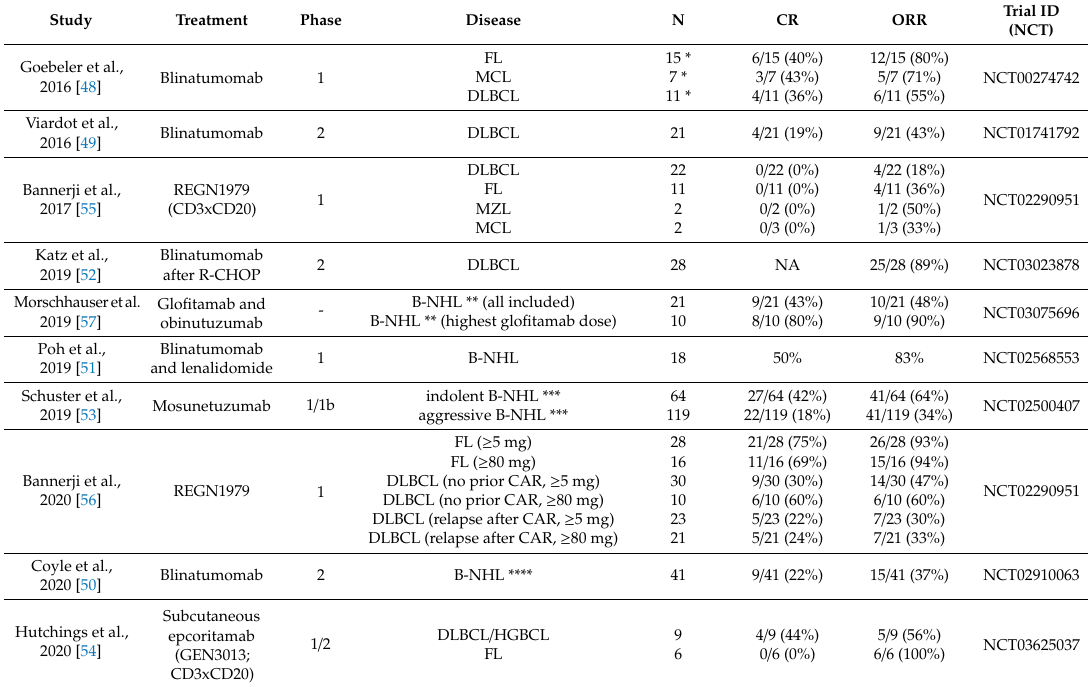
Table 2. Reported studies of bispecific antibodies in